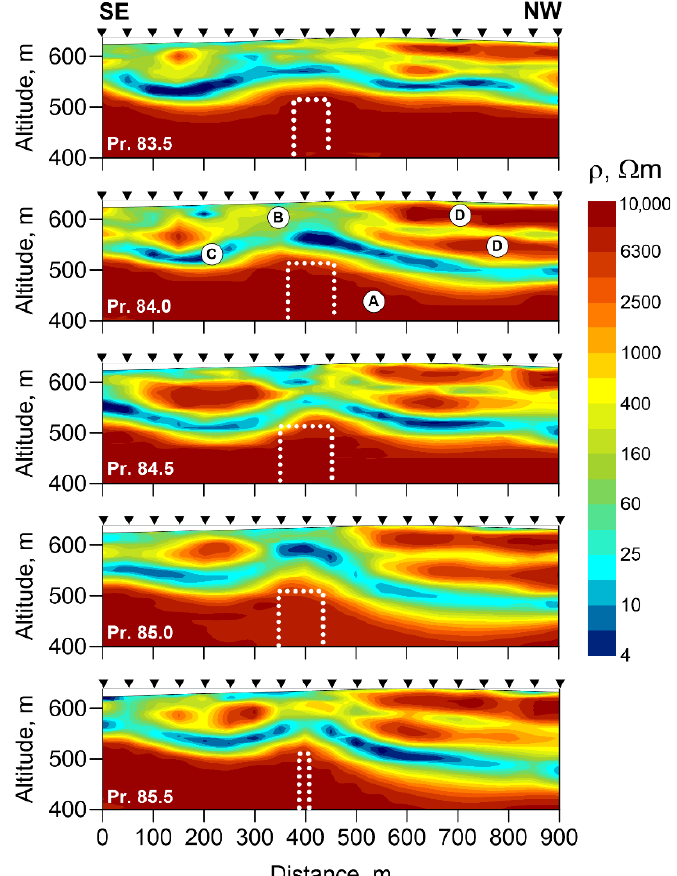
Figure 9. Resistivity sections along the profiles at the kimberlite pipe TSNIGRI. White dashed lines — contours of the pipe, black triangles — sounding stations. Blocks in resistivity sections: A — hosting carbonate rocks, B — overlying sediments, C — carbonaceous siltstones, D — dolerites.